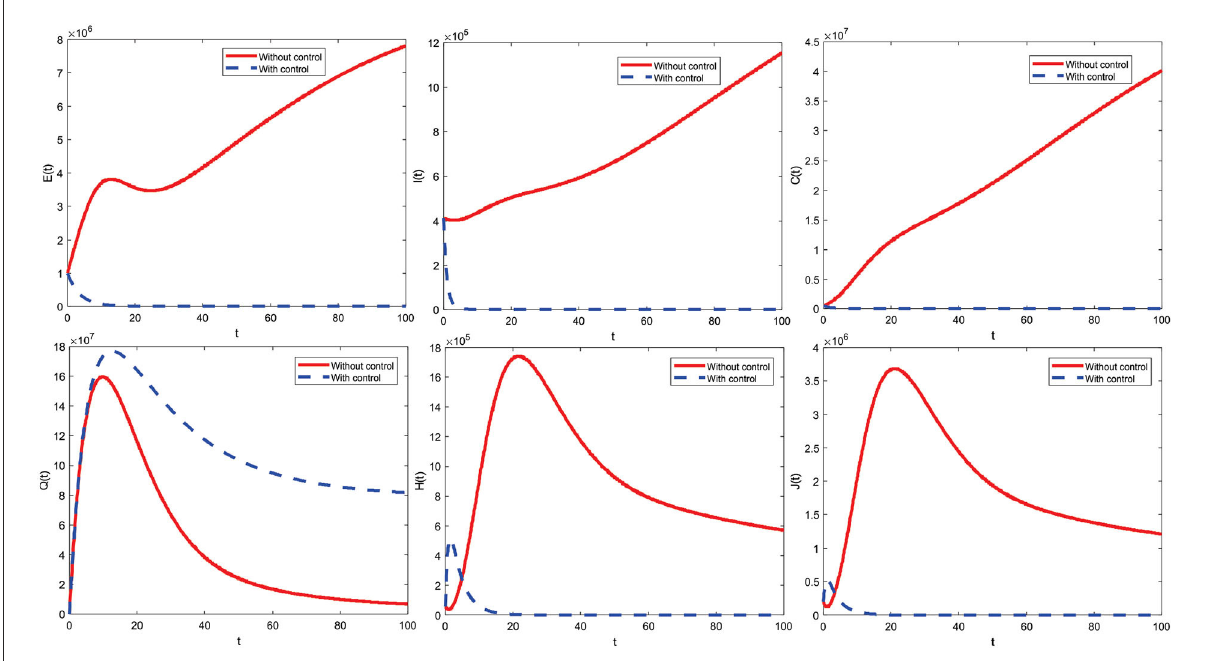
FIGURE11 Combined optimal control simulation results.